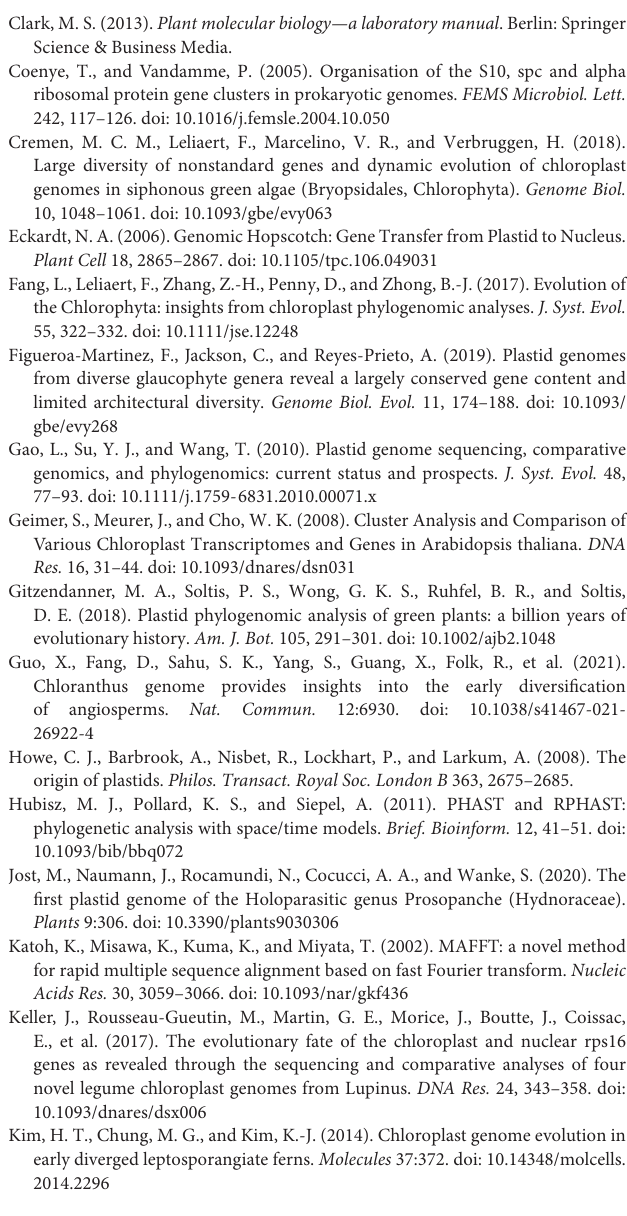
Supplementary Figure 9 | Summary of the phylogenomic tree based on matrix aa of 72 protein-coding genes of 3,654 green plants and 1,901 species obtained from earlier reports using IQTREE. Supplementary Table 1 | The detailed information and characters of the species used in this study, including species information (species name, genus, family, order, data source), genome size, GC content, gene number, and intron number. Supplementary Table 2 | The conserved gene order among Streptophyta. Different colors represent different genes. Supplementary Table 3 | The gene blocks frequency in Streptophyta. The first column represents the gene block, and the second column is the number of times the gene block was observed in 1,517 ptDNA. Supplementary Table 4 | Description of hexadecimal colors is used in Supplementary Figures 6–8